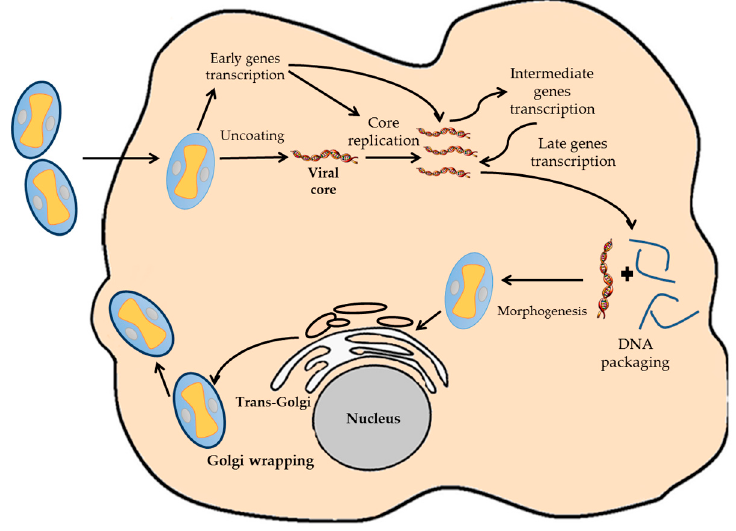
Figure 1. Diagram representative of the VACV infection cycle. The different steps of the VACV cycle are indicated.